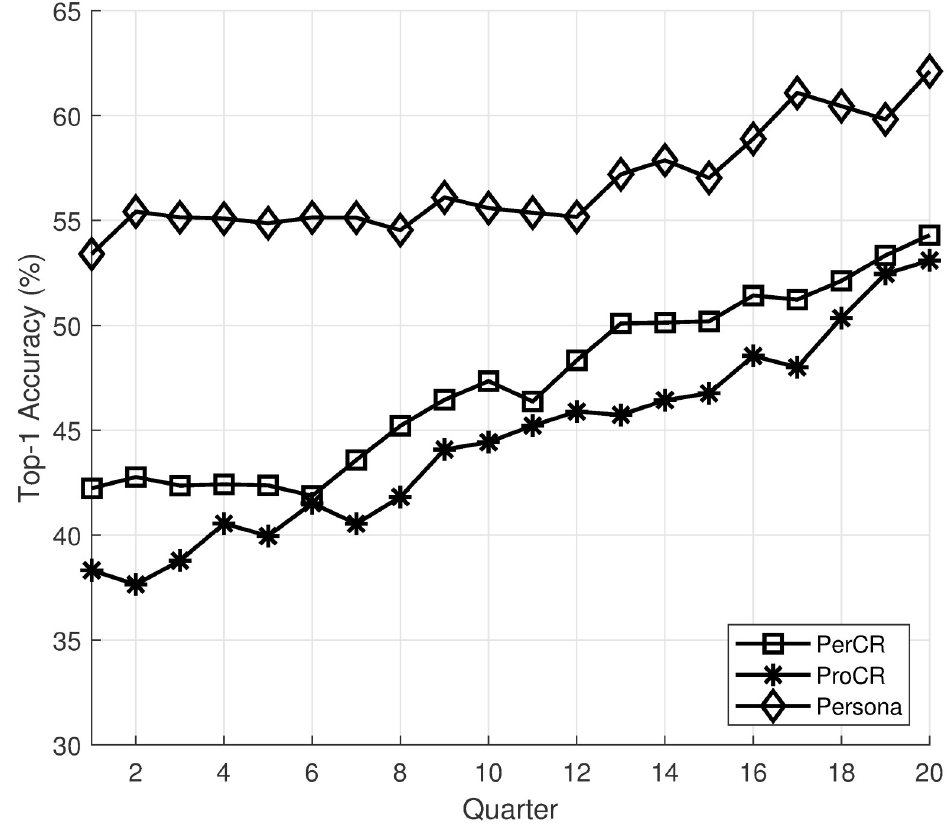
Fig 5. Top-1 accuracy over time of “Dmitry